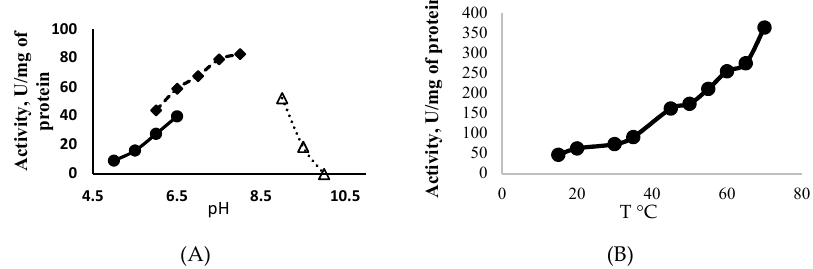
Figure 2. Effect of the pH ( A ) and the temperature ( B ) on the activity of ATP-dependent glucokinase from Methylomonas sp. 12.